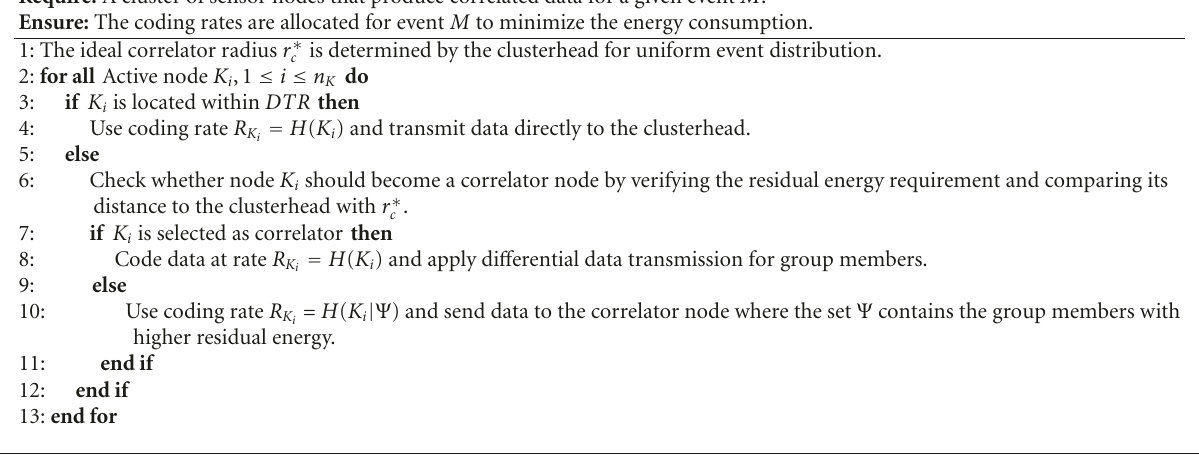
Algorithm 3: Coding rate assignment.